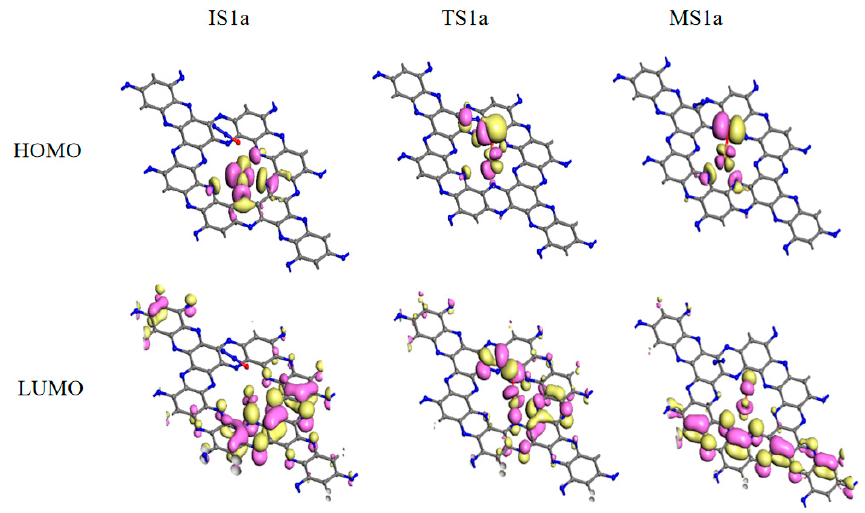
Figure 6. The frontier molecular orbitals (FMOs) for rate-determining step IS1a → TS1a → MS1a in N 2 O reduction mechanism I on Cu/C 2 N . (The isovalue was set as default value, 0.03 a.u.) .